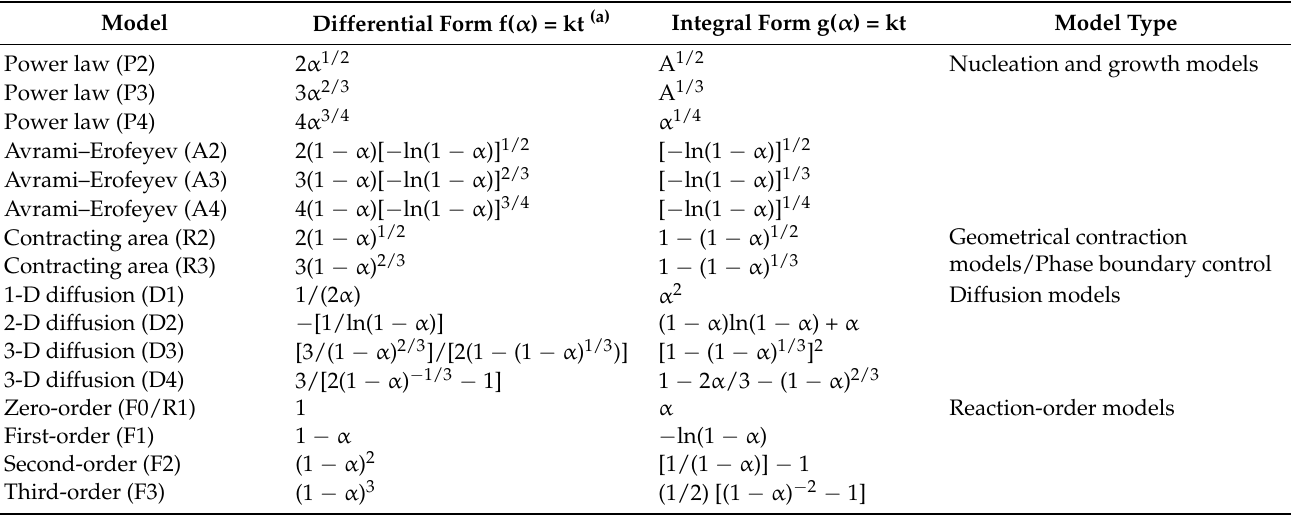
Table 4. Solid-state rate and integral expressions for different reaction models